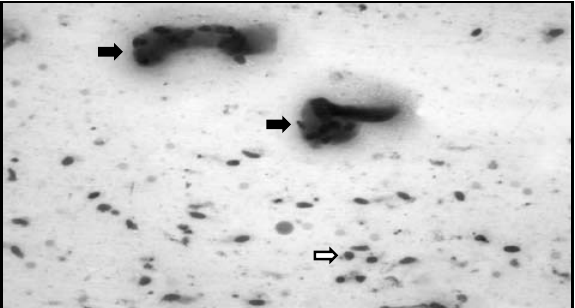
Figura 1 – Esfregaço citológico mostrando moderado número de fibroblastos isolados (seta branca) e duas células musculares degeneradas (setas pretas) (Giemsa, 100x)